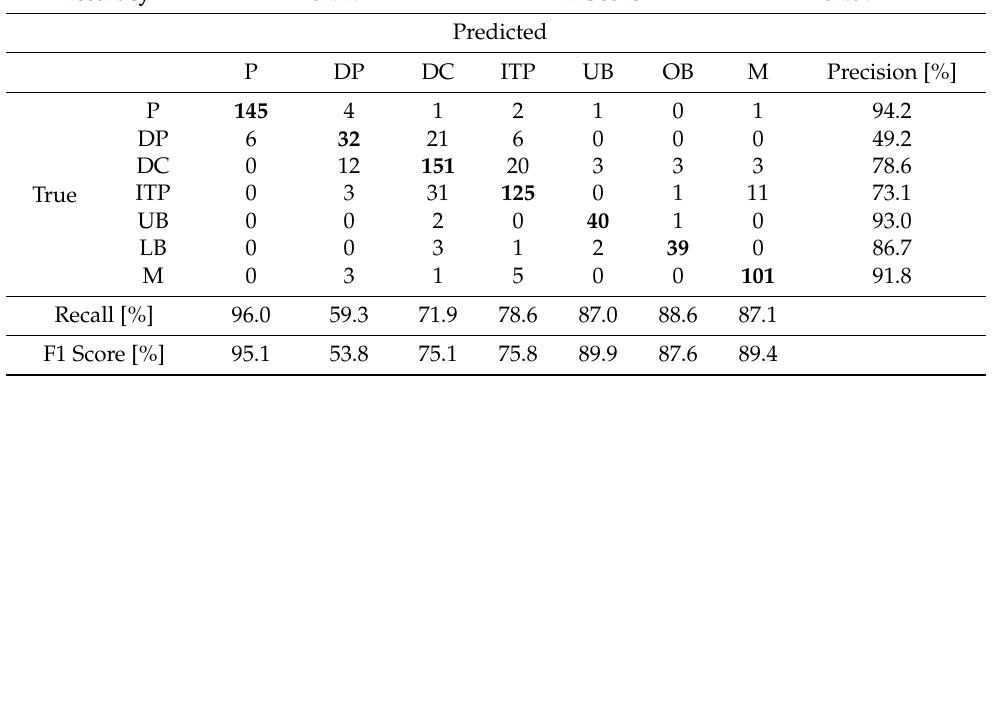
Table 3. Confusion matrix of classification strategy 1 (seven classes at once).